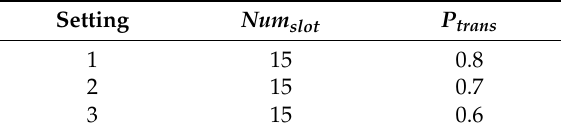
Table 8. Parameter settings with P th as variable.